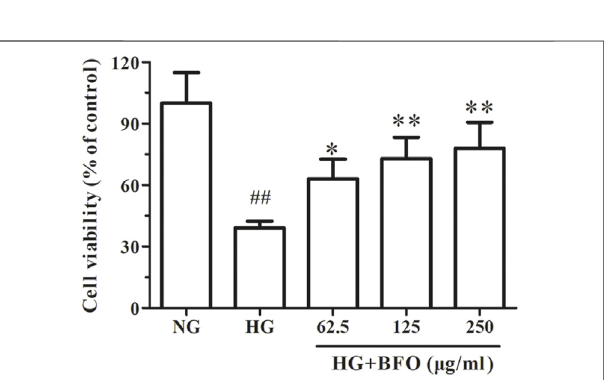
FIGURE 2 | Effect of BFO on the viability of NRK-52E cells. The cell viability was determined by a Cell Counting Kit-8 (CCK-8) test of NRK-52E cells cultured with high glucose (HG) and different concentrations of BFO. All data are expressed as the mean ± SD. ## p < 0.01 vs. normal glucose (NG), * p < 0.05 vs. HG, ** p < 0.01 vs.